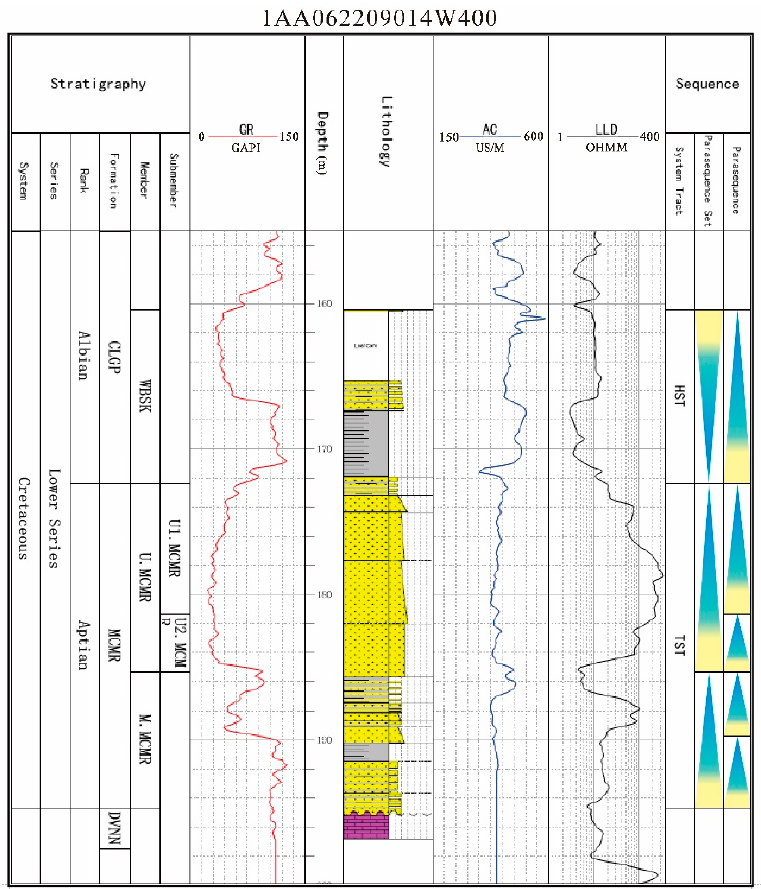
Figure 2. Stratigraphy of the Lower Cretaceous Athabasca oil sand area. WBSK: Wabiskaw member; U.MCMR: upper McMurray Formation; M.MCMR: middle McMurray Formation. The lower McMurray Formation is missing in this